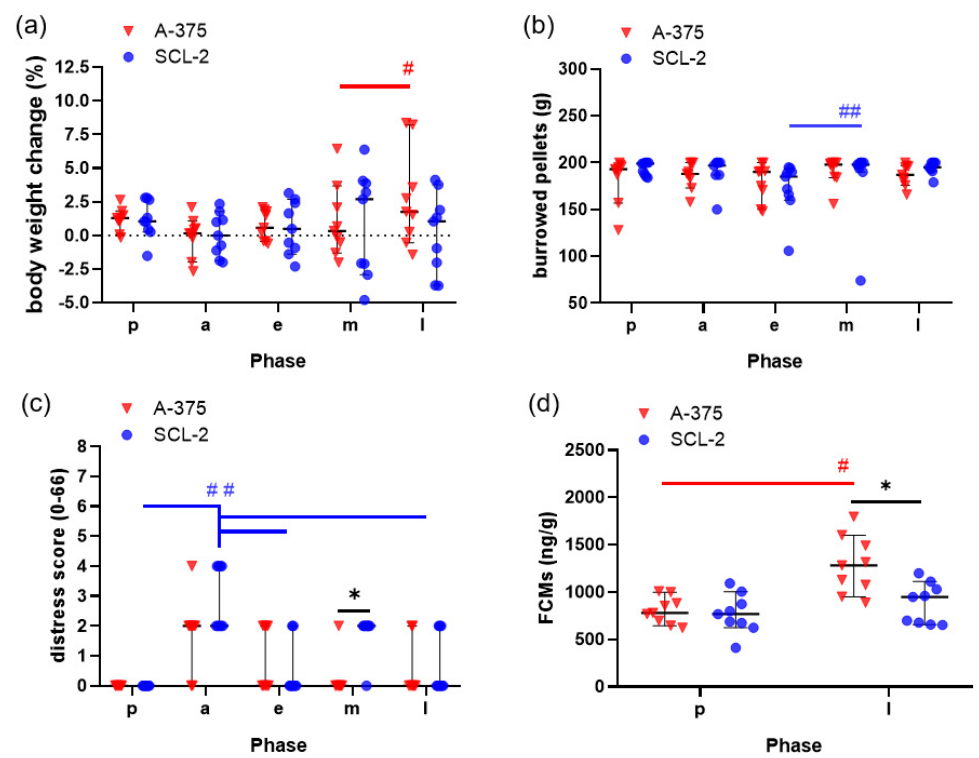
Figure 2. Evaluation of distress during the growth of the A-375 and SCL-2 tumors in mice during pre- (p), acute (a), early (e), middle (m) and late (l) phase. ( a ) Percentage of body weight change, ( b ) burrowing activity, ( c ) distress score and ( d ) concentration of faecal corticosterone metabolites (FCMs). Graph ( a ): # p = 0.0366; ( b ): ## p = 0.0287; ( c ): * p = 0.0034, ## p ≤ 0.0175; ( d ): * p = 0.0013, # p < 0.0001; A-375: n = 9, SCL-2: n = 9.